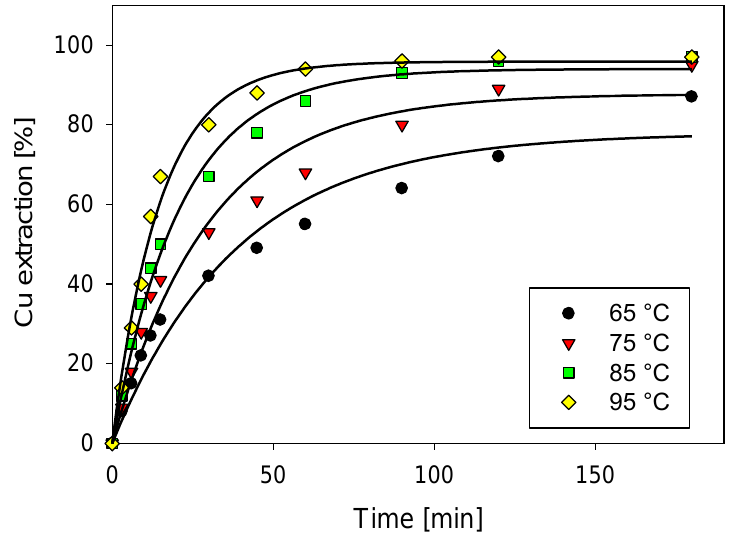
Figure 8. Cu 2 S dissolution as a function of temperature (0.5 mol/L H 2 SO 4 and 100 g/L of Cl − )